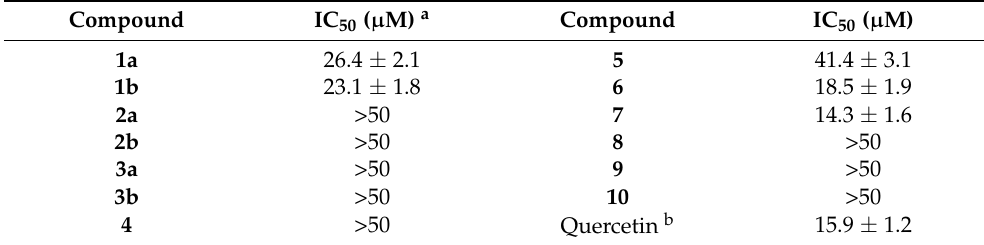
Table 2. Inhibition of LPS-induced NO